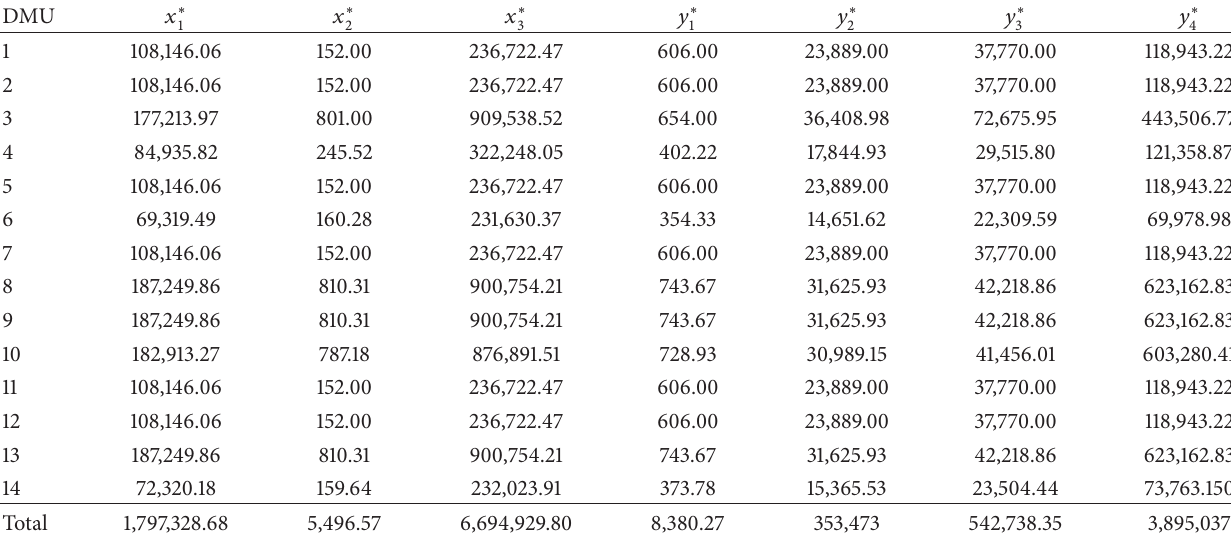
Table 5: Benchmarks for each branch by using the proposed